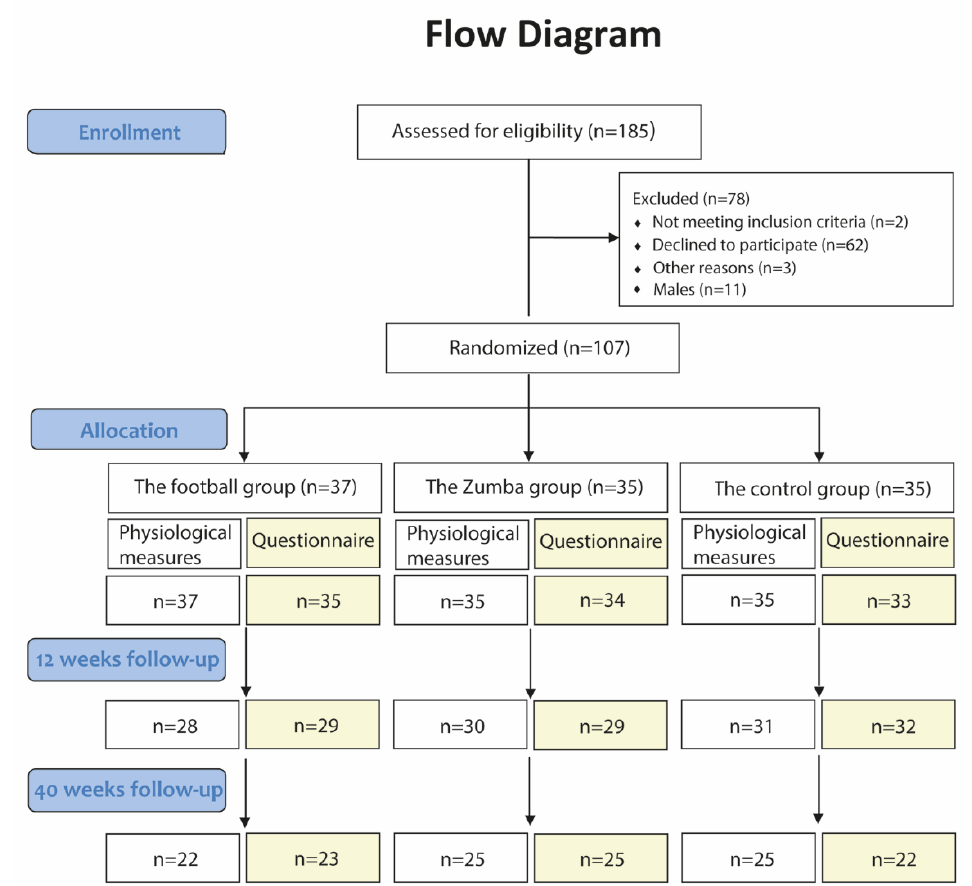
Figure 1. Flow diagram showing the number of participants initially enrolled in the study and randomized to the three groups, as well as the number of drop-outs throughout the 40 weeks intervention period related to (i) the objective physiological measurements and (ii) the online questionnaire, respectively.